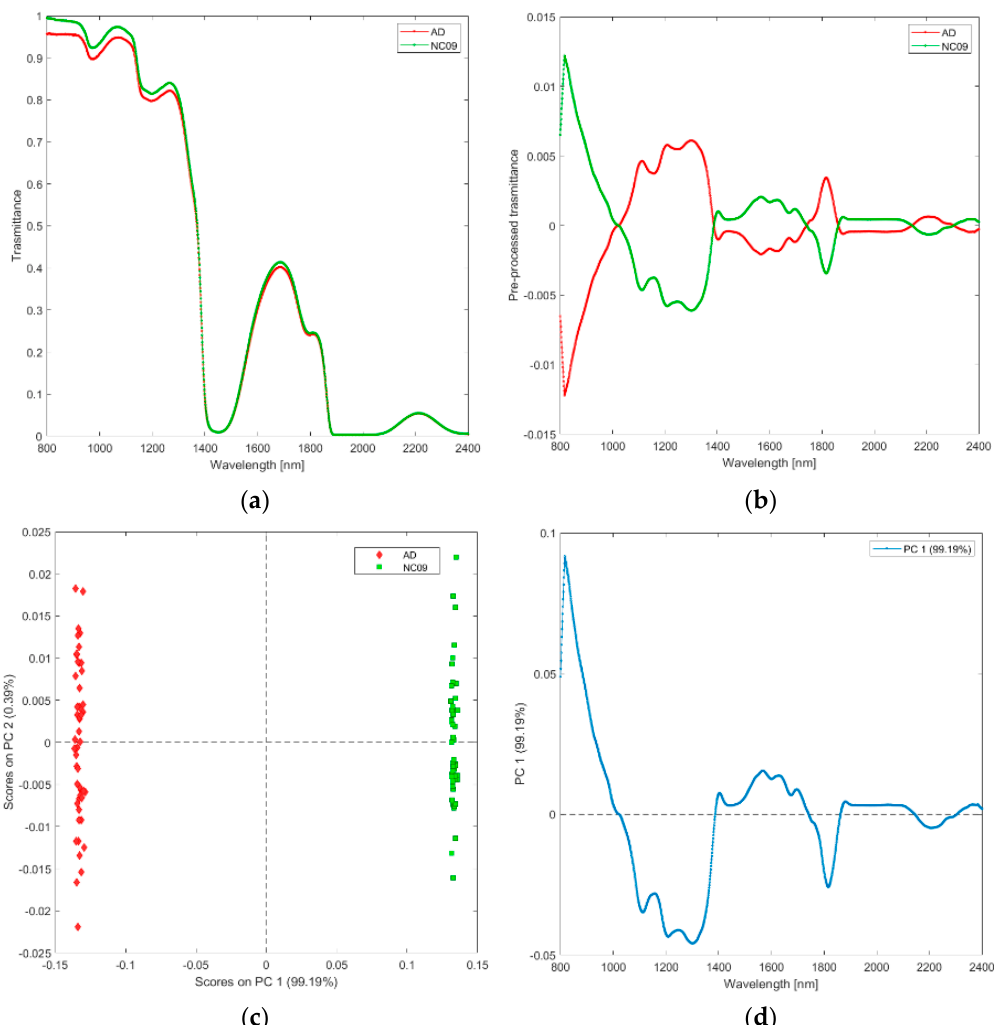
Figure 11. Average raw ( a ) and pre-processed ( b ) transmittance spectra for saline (NaC09), and water (AD). PC1 − PC2 score plot ( c ) and loading plot of PC1 ( d ) for saline (NaC09), and water (AD).